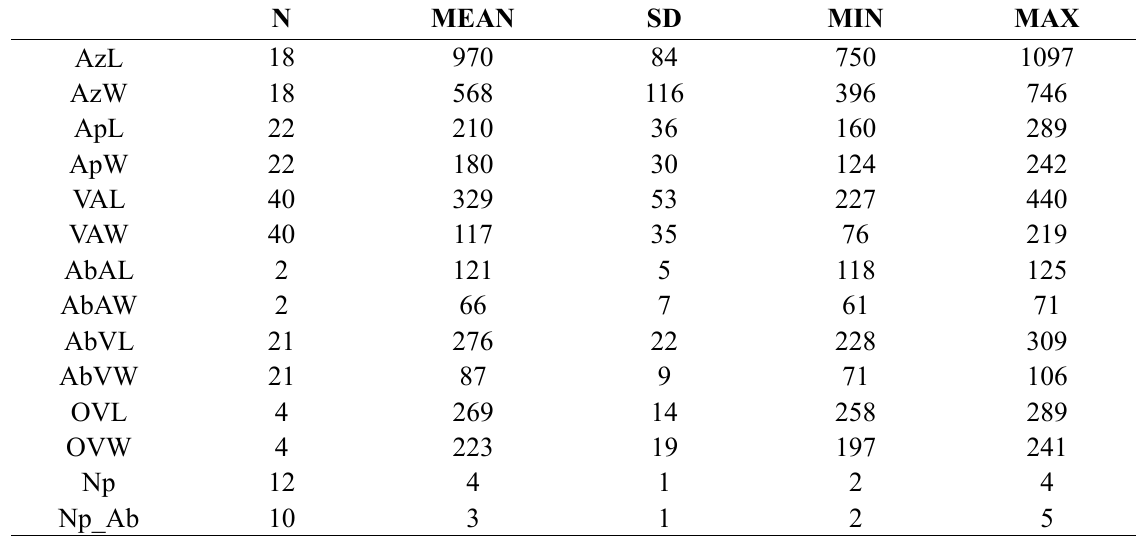
Table 1. Measurements of Schizoretepora calveti d’Hondt,